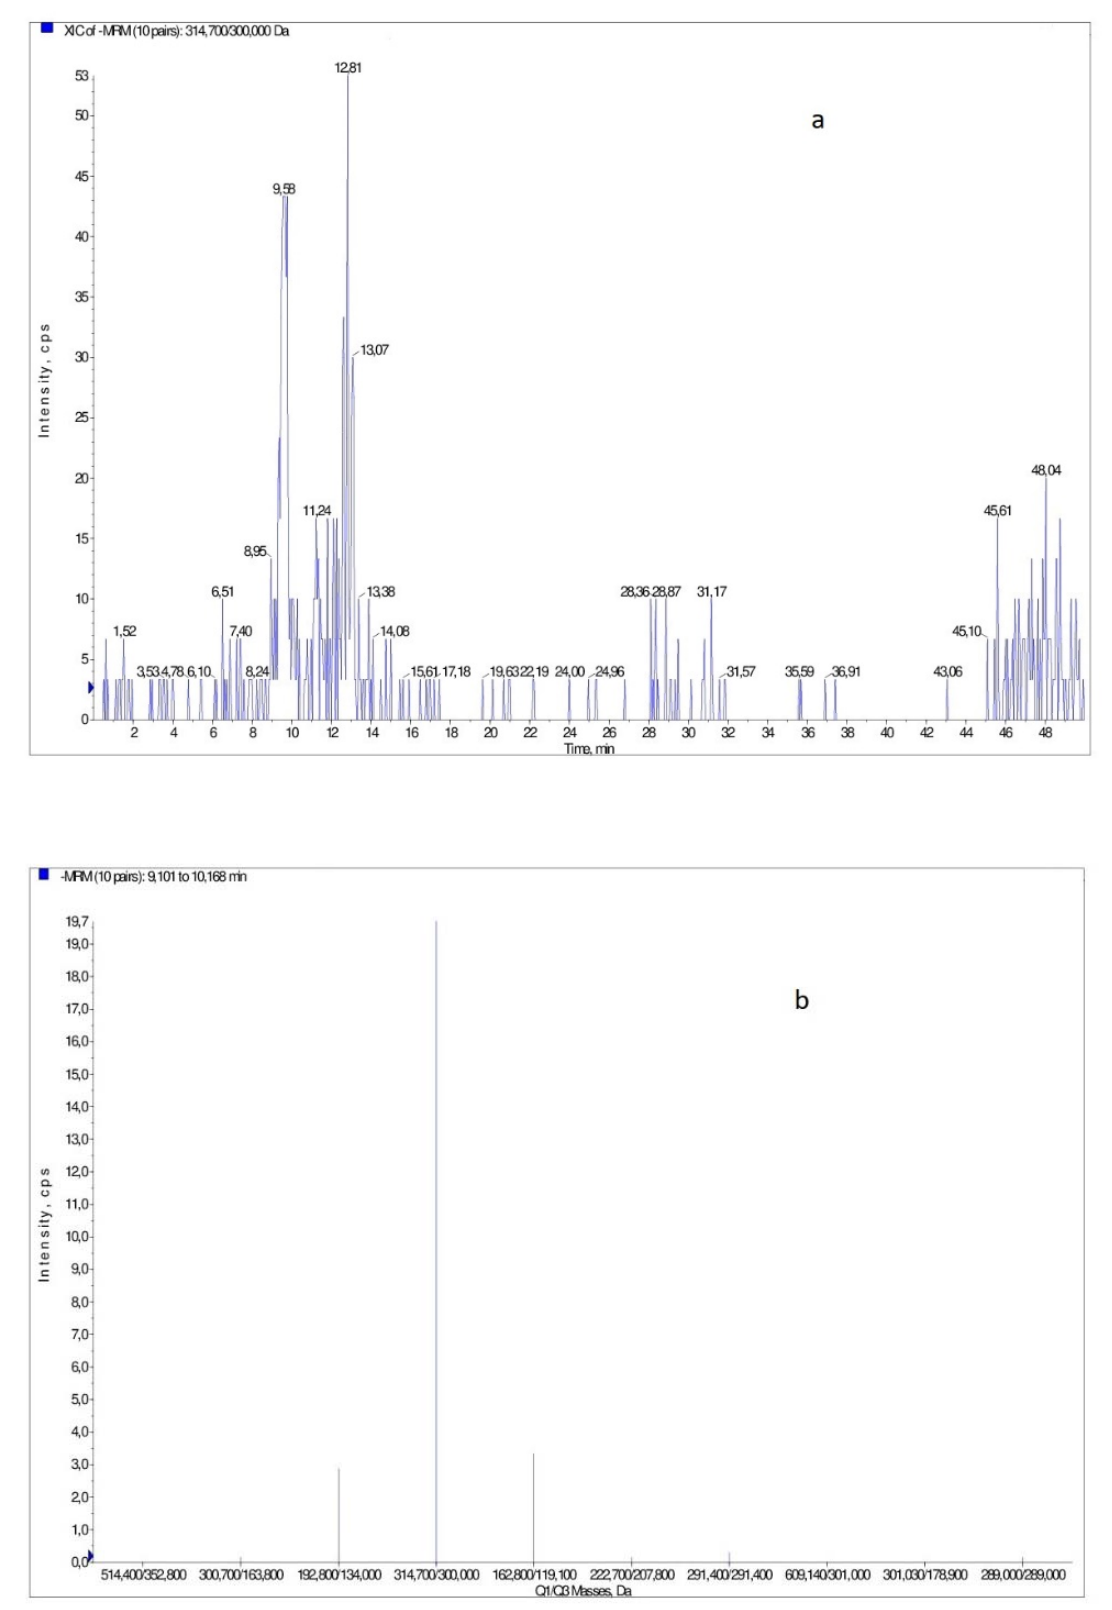
Figure 2. ( a ) Example of a XIC chromatogram obtained for a sample of Ornak collected in May. The chromatogram was obtained for the pair of ions m / z = 314 / 300, identified as isorhamnetin; ( b ) Fragmentation mass spectrum (MS / MS for m / z = 314 − isorhamnetin).